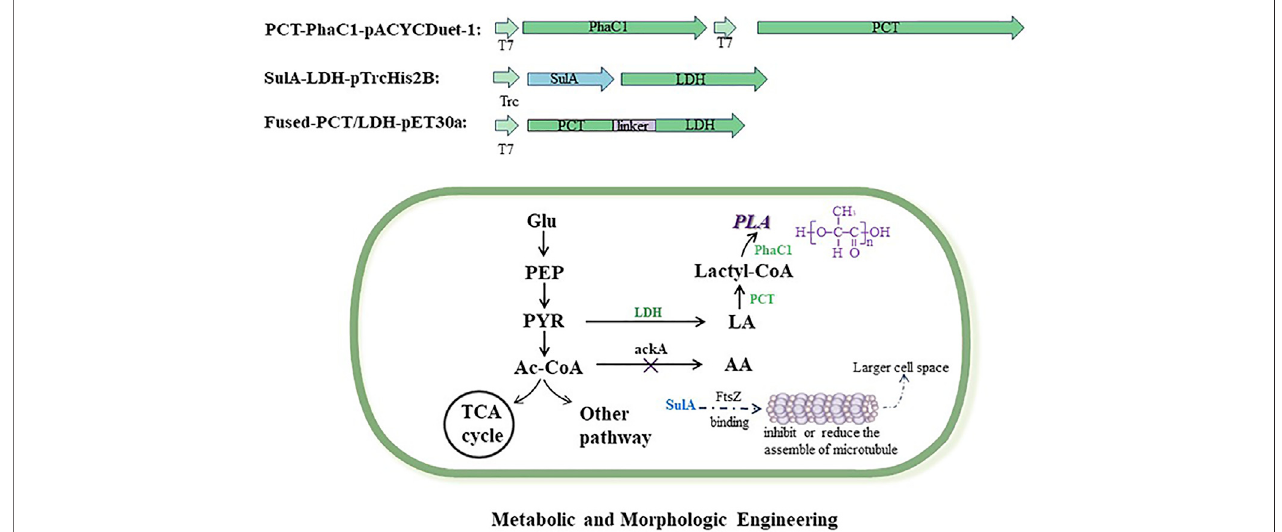
FIGURE1| Metabolicandmorphologicengineeringof E.coli strainsforpolylacticacidproduction. Exogenousvectorsexpressedthegenesofkeyenzymeswhich are involved in the biosynthesis pathway of polylactic acid. The gene of ackA was deleted in the engineered strains to reduce the competitive by-product of acetic acid. The gene of sulA was expressed in engineered stains for larger cell space. Full names of abbreviations are as follows: PLA, polylactic acid; PhaC, PHA synthase; PCT, propionyl-CoA transferase; LDH, lactate dehydrogenase; Glu, glucose; PEP, phosphoenolpyruvate; PYR, pyruvate; Ac-CoA, acetyl co-enzyme A; AA, acetic acid; LA, lactic